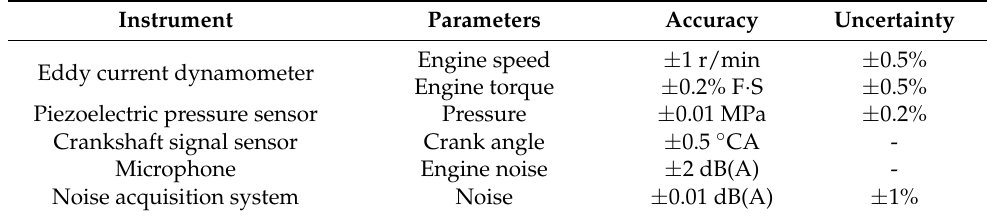
Table 3. Accuracy and uncertainty of the measured